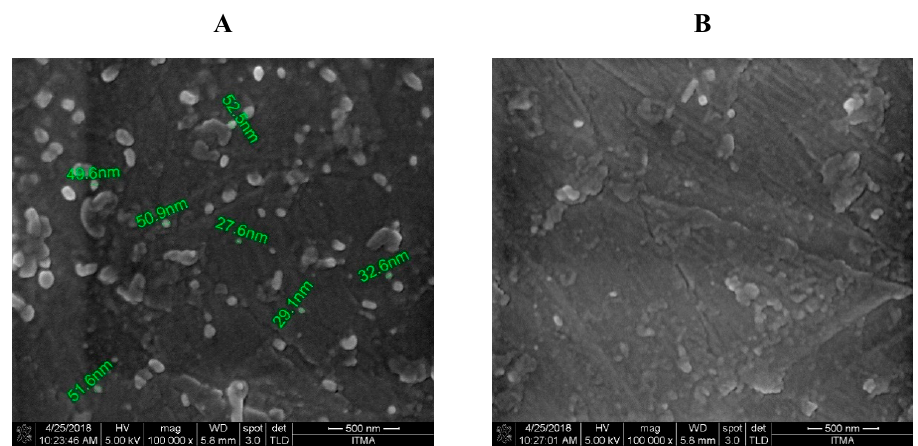
Figure 13. SEM micrographs of CS-AlgNPs ( A ) and MET-CS-AlgNPs ( B )(100000×). 398